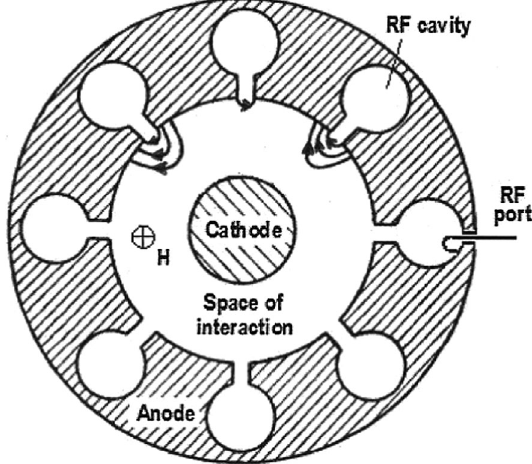
FIG. 1. Schematic sketch of a conventional 8-cavities magnet- ron. The lines in the space of interaction represent the rf electric